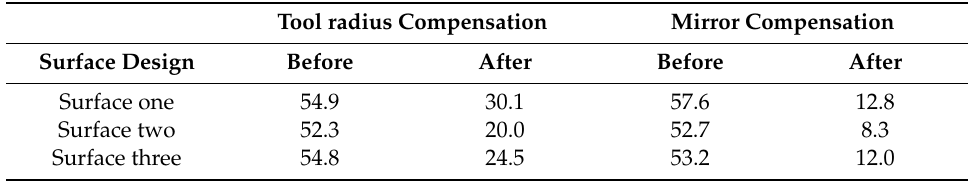
Table 4. Surface profile error for the three surfaces by using the tool radius compensation or the mirror compensation, unit: µ